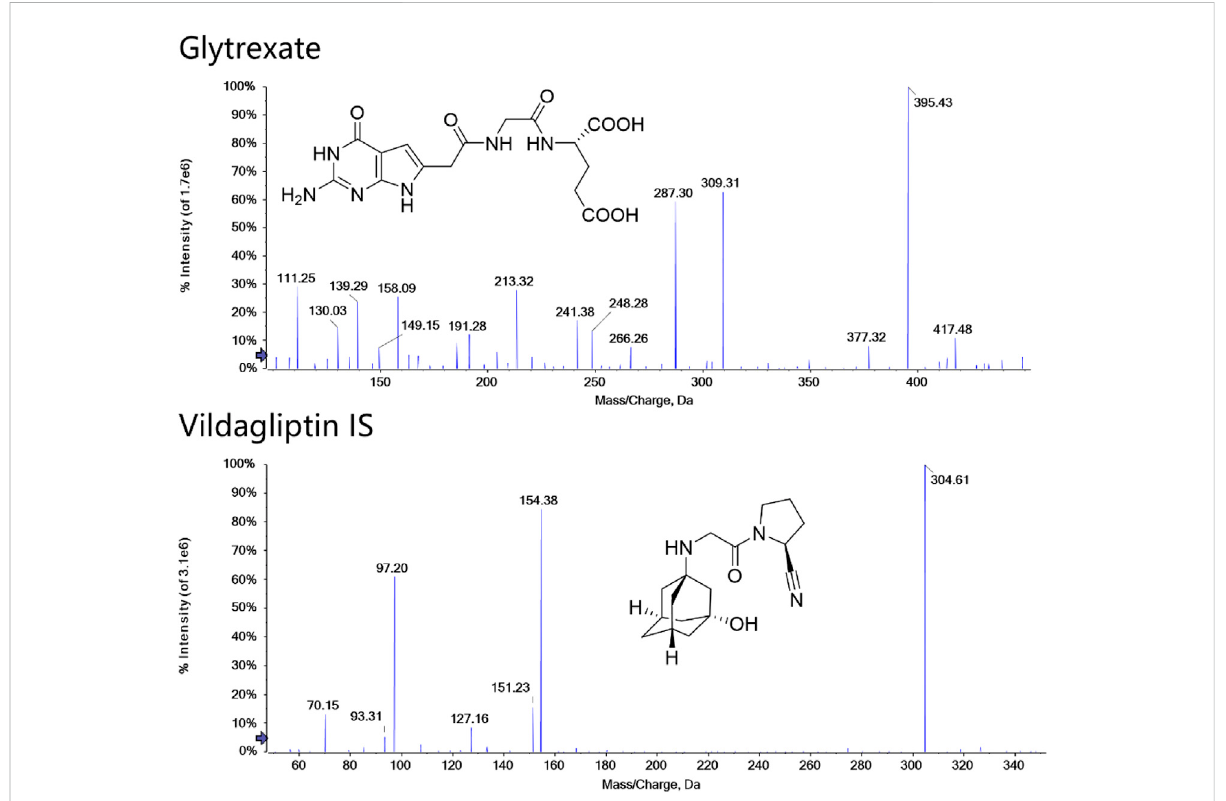
FIGURE 1 Structures and MS/MS spectra of glytrexate and the IS. MS/MS data were obtained from the respective [M+H] + ions as the precursors for collision-induced